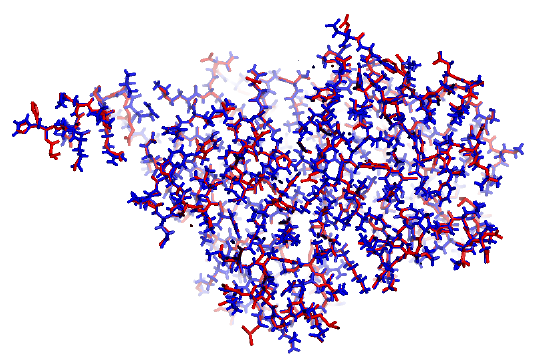
Figure 9. Comparison of the reconstructed model (blue) with the PDB model (red) of the test structure.